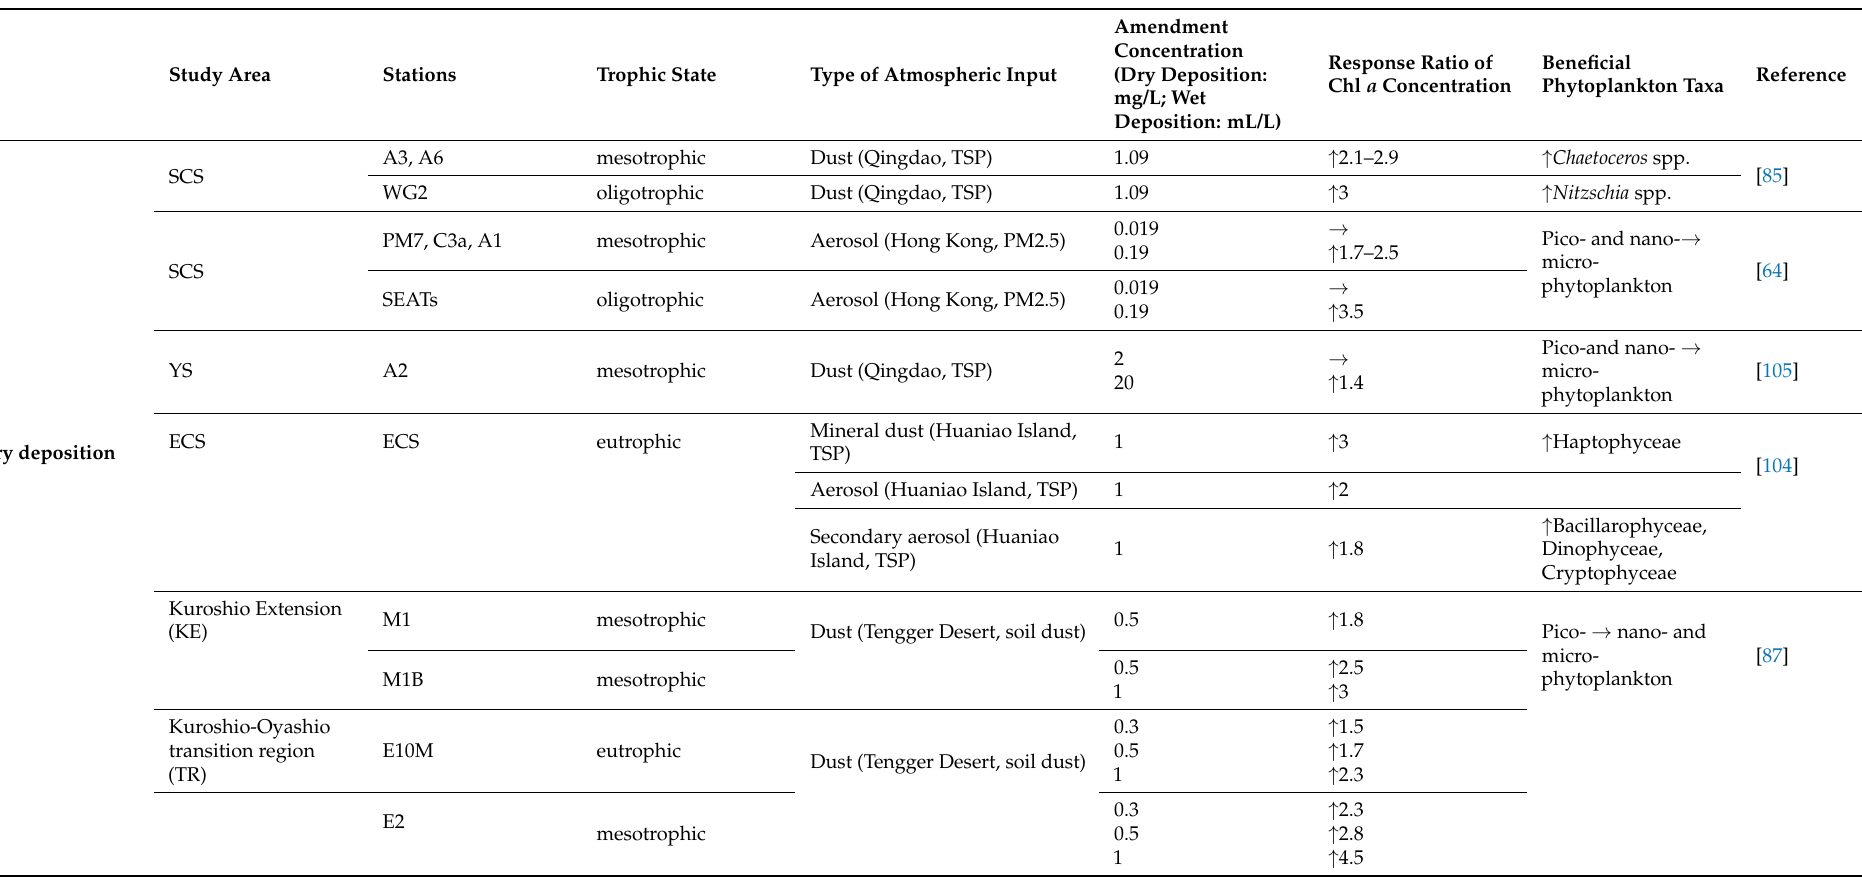
Table 1. Bioassays with atmospheric dry and wet deposition amendment showing changes of phytoplankton biomass and community structure in NWPO and